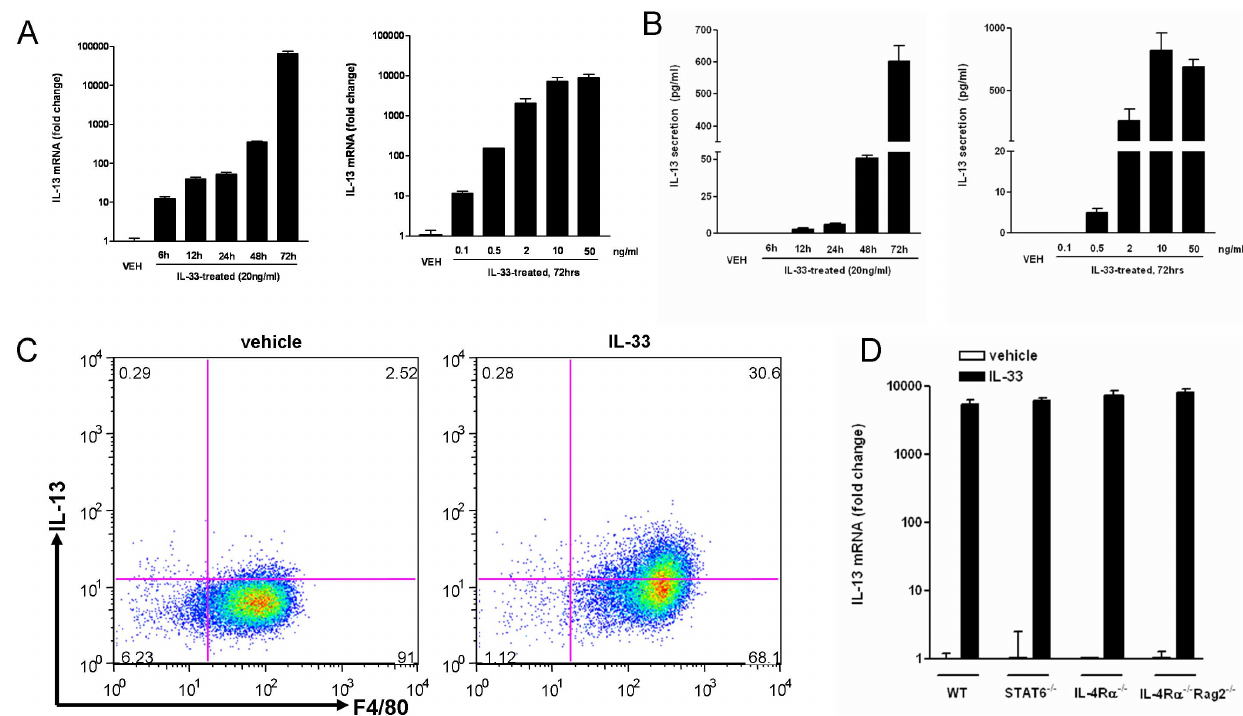
Figure 1. IL-33 stimulated macrophages to produce IL-13 invitro . A, B, Time- and concentration-dependent upregulation of IL-13 mRNA expression (A, qPCR) or IL-13 secretion from cell culture supernatants (B, ELISA) in BMDM stimulated with IL-33. C, After IL-33 stimulation, BMDM were stained with antibodies, and analyzed by FACS for surface F4/80 and intracellular IL-13 expression. D, BMDM from WT, STAT6 2 / 2 , IL-4R a 2 / 2 , or IL- 4R a 2 / 2 Rag2 2 / 2 mice were stimulated with IL-33, and analyzed for IL-13 mRNA expression (72 hours) by qPCR. Data shown in bar graphs are the mean 6 s.e.m and representative of at least two independent experiments.